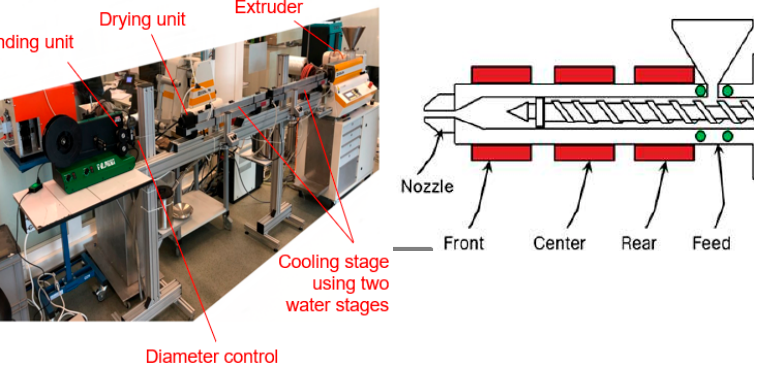
Figure 6. Filament extrusion line at Institute of Polymer Engineering, FHNW University of Applied Sciences and Arts, Northwestern Switzerland.